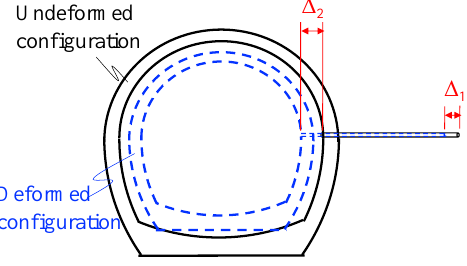
Figure 8. Schematic diagram of the anchor ratio ( ∆ 1 / ∆ 2